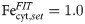
Iron-based derepression mechanism of iron storage is not active at low external iron concentrations.The figure shows that the iron-based derepression mechanism for iron storage (Fig 6a) cannot activate iron storage at low external iron concentrations when the IRT1 high-affinity uptake system is active. In this calculation the external iron concentration Feext is kept constant at 1.0. Initial concentrations and rate constants for this calculation are as in Fig 6b and 6c, except for k22 (= 0.1) which accounts for a symplastic removal of iron out of the vacuole and leads to a decrease in Festore. The FIT and IRT1-based high affinity uptake is able to keep the cytosolic iron at its set-point Fecyt,setFIT=1.0, while the S-based outflow controller (Fig 6a), responsible for iron storage, is inactive.